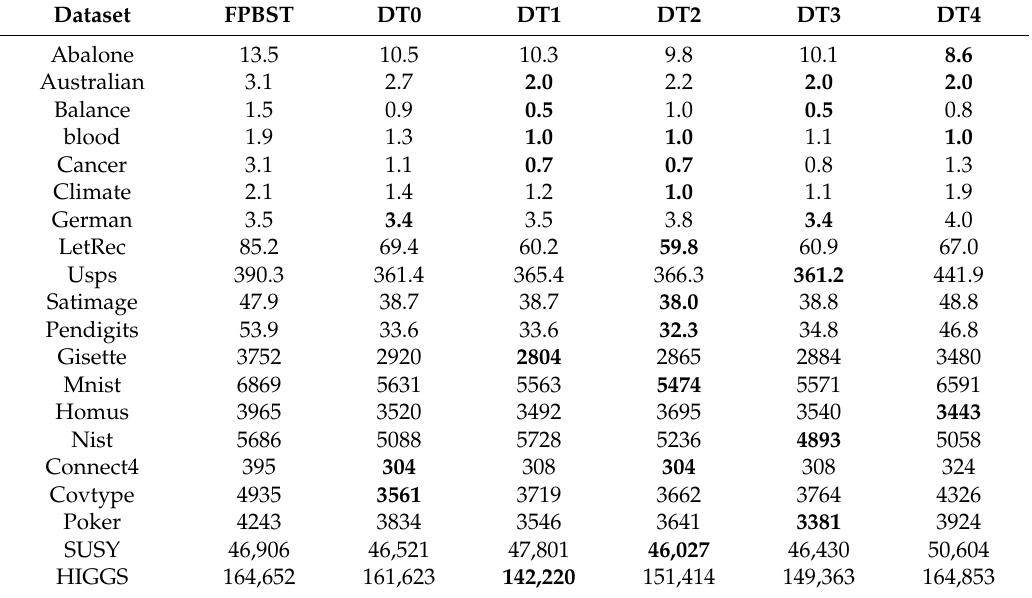
Figure 7. Illustration of data from Table 5 (time (ms) consumed by the proposed methods to build their DTs compared to that of the FPBST), the time axis is logarithmic base-10. Table 6. Time (ms) consumed by the FPBST to test the entire test examples compared to that of the proposed methods DT0–DT4, this is the average test time of the 10 folds.